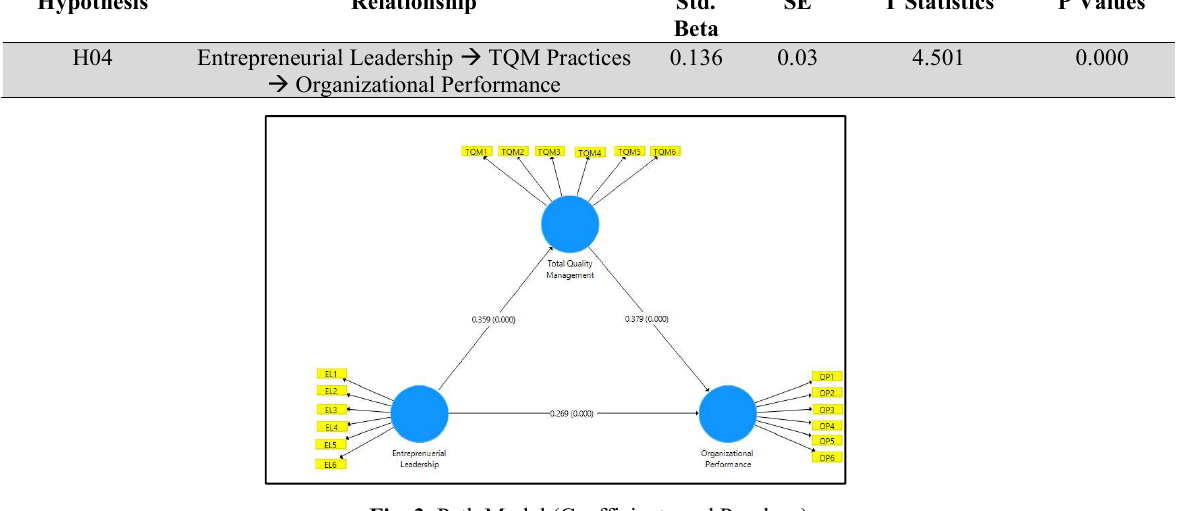
Fig. 3. Path Model (Coefficients and